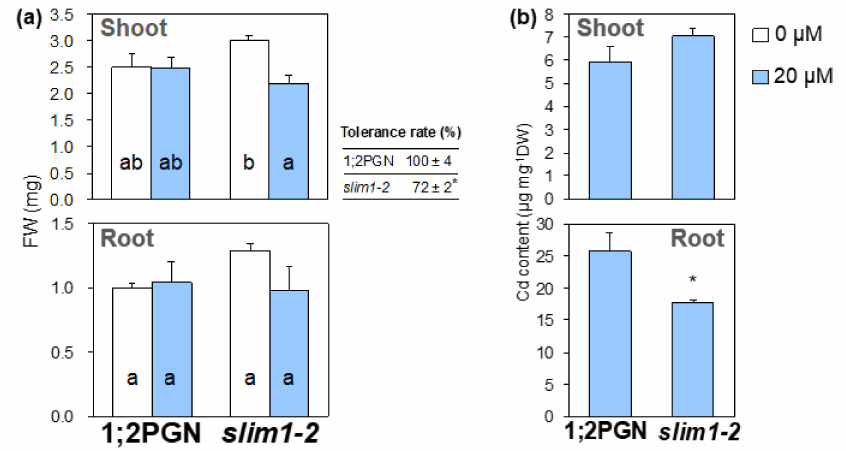
Figure 1. E ff ects of Cd treatment on plant growth and Cd accumulation in 1;2PGN and slim1-2 . ( a ) Fresh weight of shoots (upper graph) and roots (lower graph). The Cd tolerance rate (%) was calculated by dividing the shoot fresh weights of the Cd-treated plants by those of the control plants. ( b ) Cd content in shoots (upper graph) and roots (lower graph). Also, 1;2PGN and slim1-2 were grown for 10 days on MGRL agar medium containing 0 (white bars) or 20 (light blue bars) µ M CdCl 2 . The average values are indicated with error bars denoting SEM ( n = 4). Di ff erent letters indicate significant di ff erences between experimental groups (Tukey-Kramer test; p < 0.05). Asterisks indicate significant di ff erences between 1;2PGN and slim1–2 (Student’s t -test; * p <